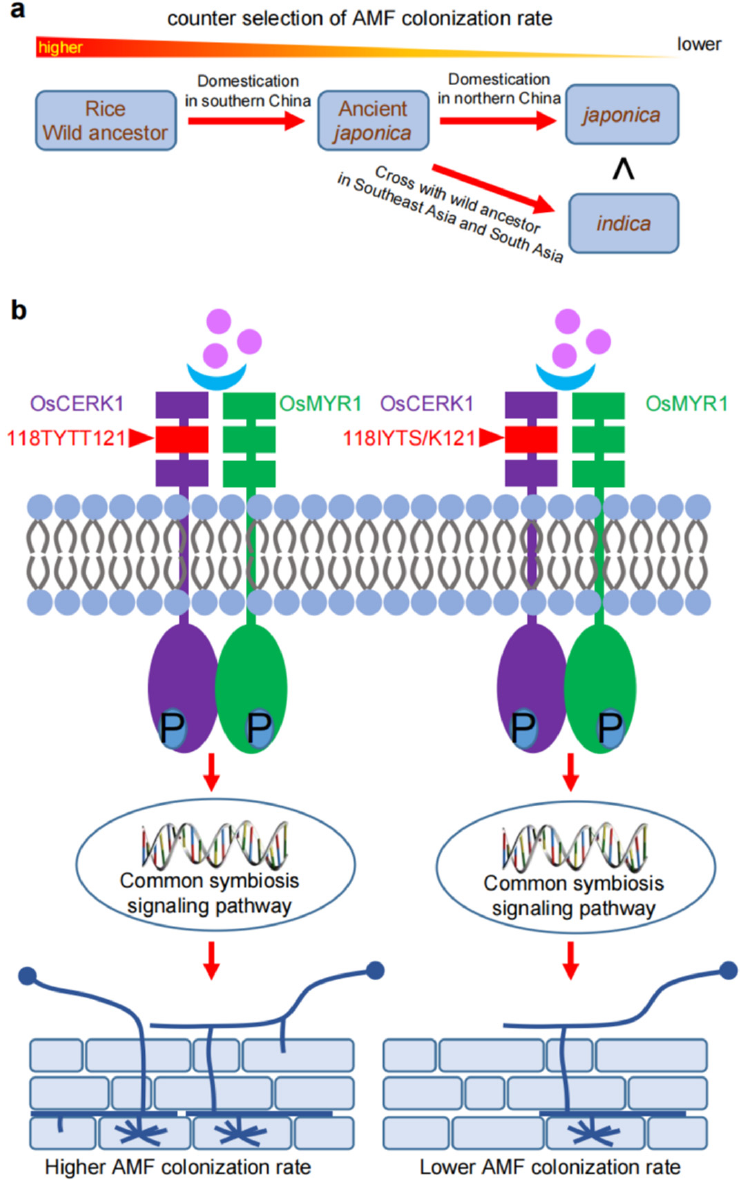
Figure 2. Natural selection of AMS during rice domestication: ( a ) the proposed selection model for AMS during rice domestication; ( b ) natural variation at OsCERK1 in regulating AMS in rice.